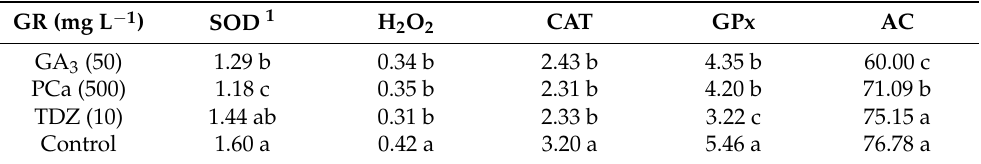
Table 4. Application of GRs in cv. Wichita pecan trees and their effects on oxidative metabolism and antioxidant